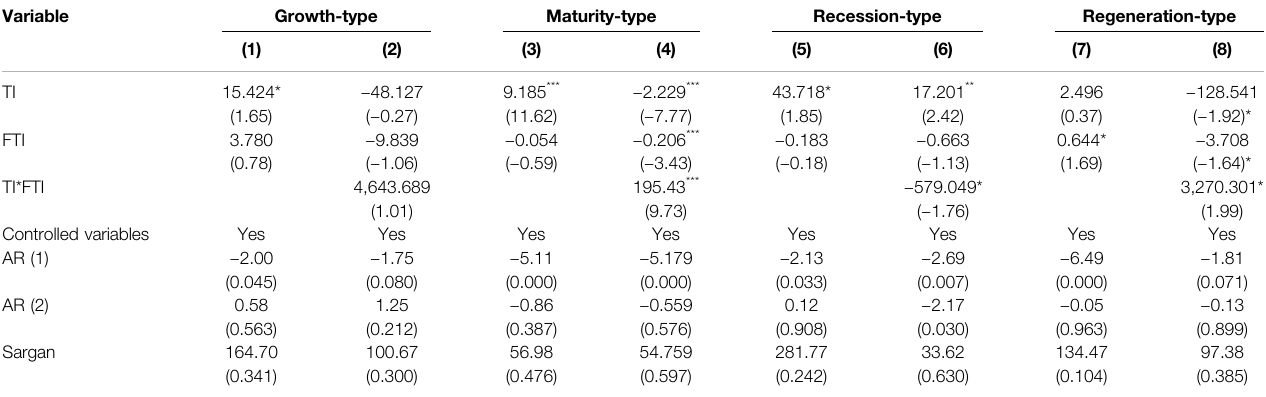
TABLE 6 | Results of the heterogeneity